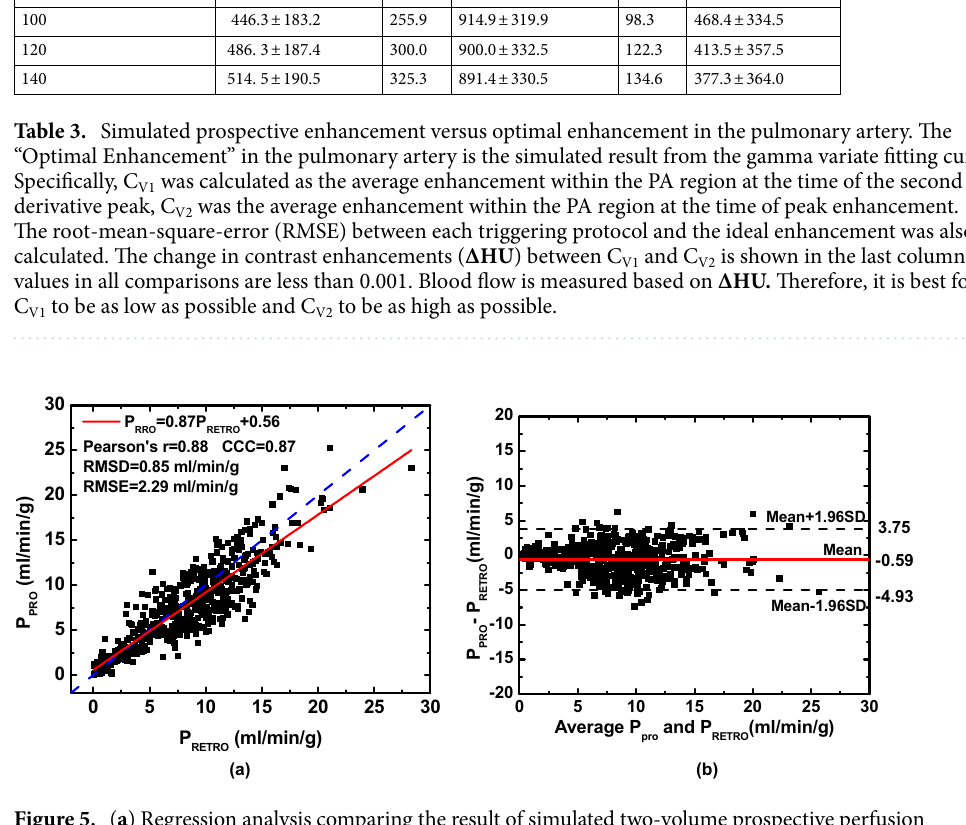
Figure 5. ( a ) Regression analysis comparing the result of simulated two-volume prospective perfusion measurements ( P PRO ) to the corresponding reference retrospective perfusion measurements ( P RETRO ). Each data point represents a 3D perfusion segment from the swine. For the retrospective assessment, the optimal V1 and V2 were selected at the base and peak of the AIF from the gamma fitting curve. For the prospective measurement, bolus-tracking simulation was conducted in the right ventricle within triggering threshold at 60 HU above the blood pool enhancement. ( b ) Bland–Altman analysis was performed with the limits of agreement. CCC: concordance correlation coefficient, RMSD: root-mean-square deviation, RMSE: root-mean-square error, SD: standard